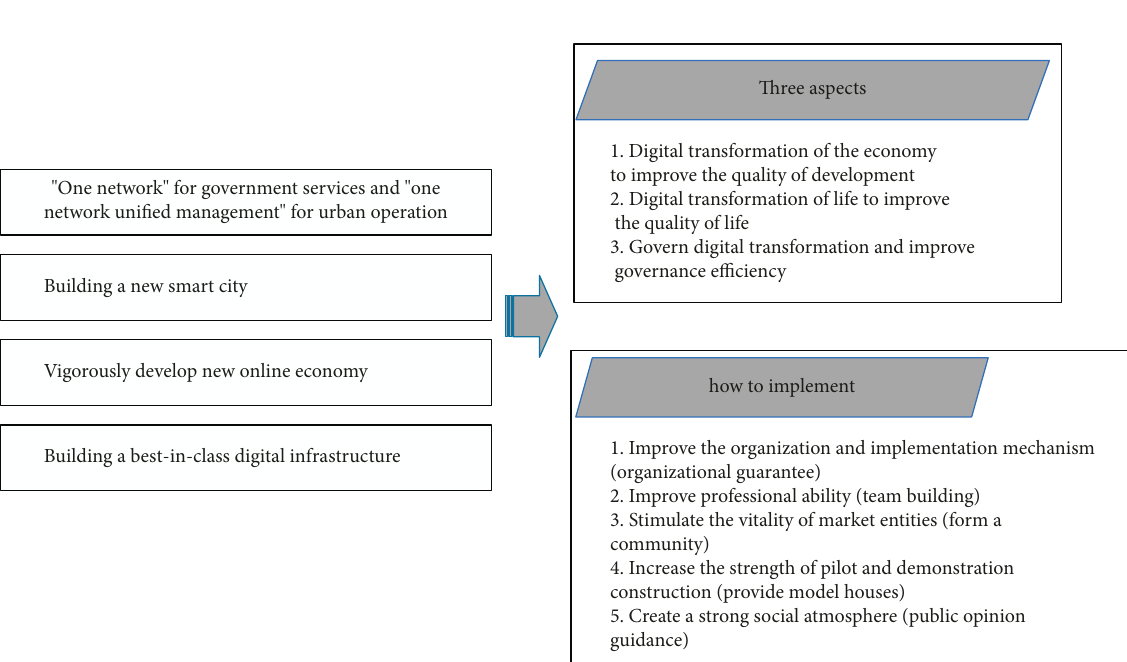
Figure 4: The path of Shanghai’s promotion of urban digitalization.